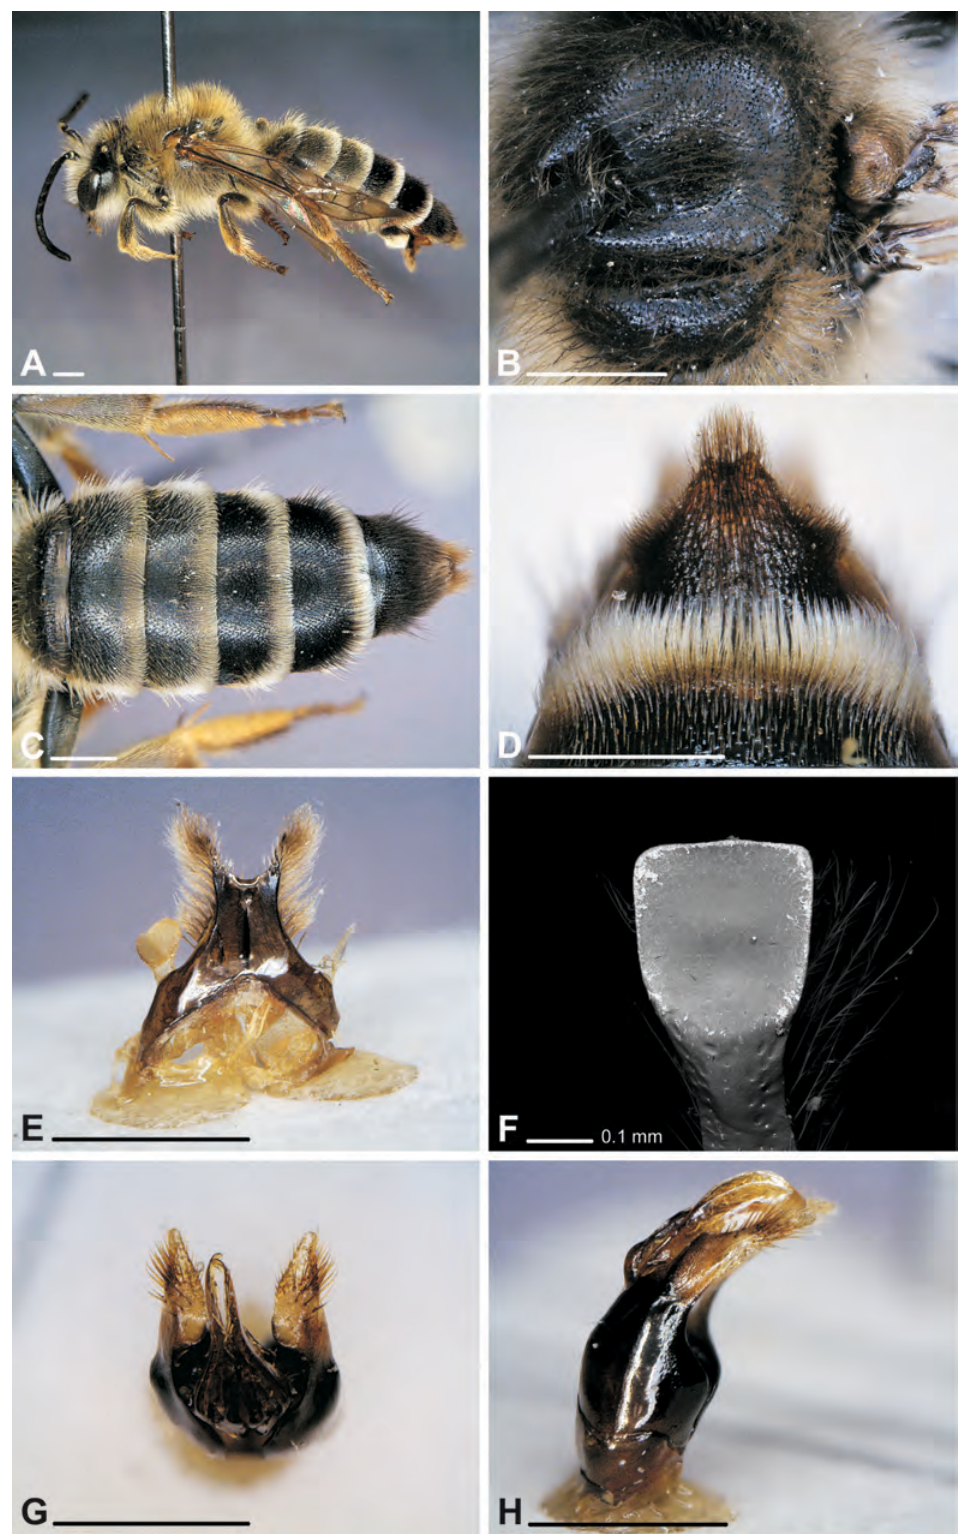
Fig. 16. Redivivoides variabilis sp. nov., ♂. A . lateral view. B . Scutum and scutellum. C . Metasoma (dorsal view). D . S6 (ventral view). E. S7 (dorsal view). F . S8, apical end (backscattered electron image). G . Genitalia (dorsal view). H . Genitalia (lateral view). Scale bar: 1